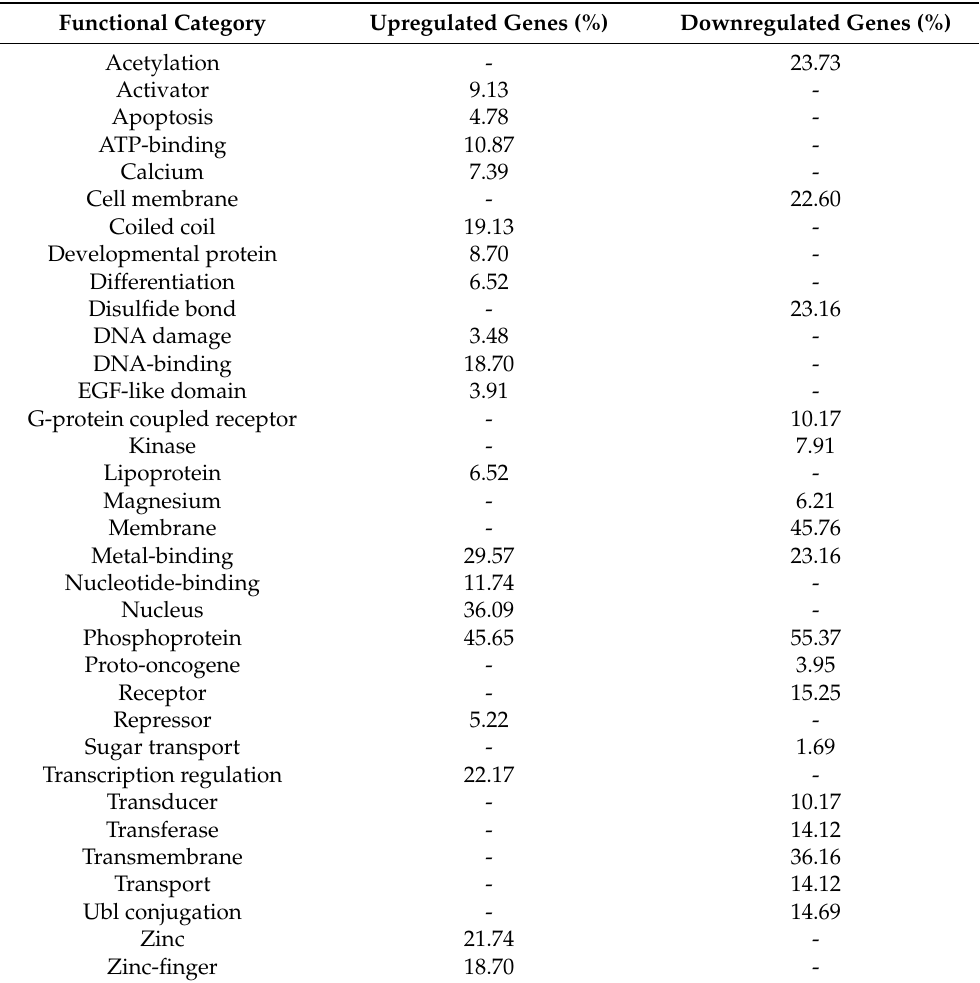
Table 5. Functional category of up- and downregulated genes from the microarray analysis performed with PC3 cells that were treated with p